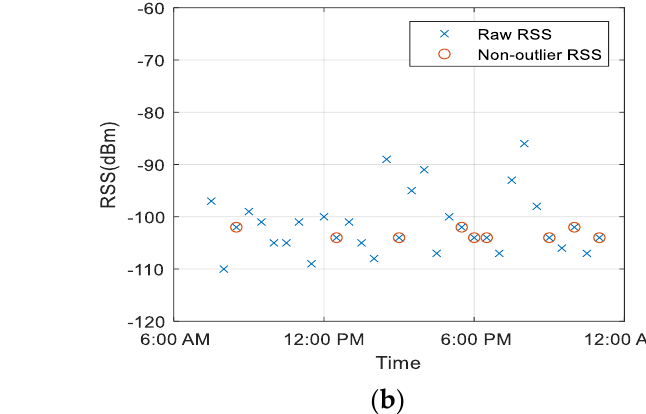
( b ) Figure 4. RSS outlier detection comparison for RSS Dataset 2. ( a ) 𝑆 𝑛 scale estimator, and ( b ) MAD scale estimator. ( a ) ( b ) Figure 5. RSS outlier detection comparison for RSS Dataset 3. ( a ) 𝑆 𝑛 scale estimator, and ( b ) MAD scale estimator.